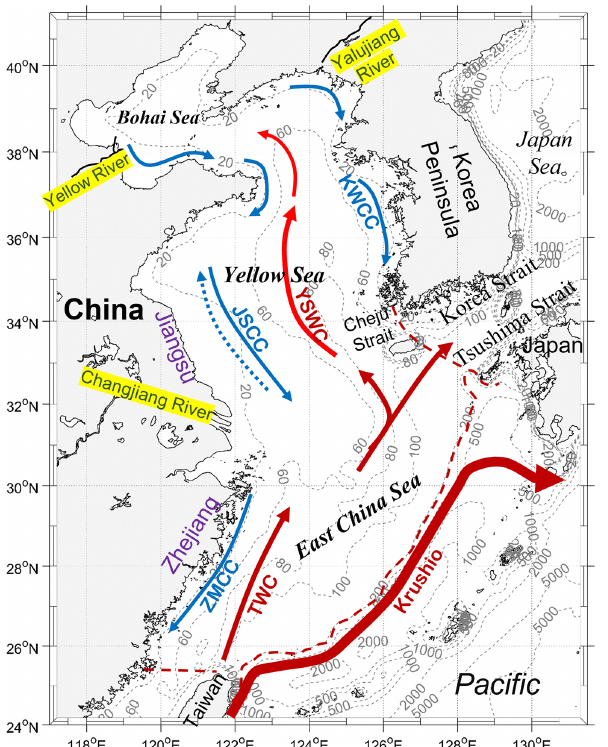
Figure 1. Model domain, locations of the Yellow, Yalujiang, and Changjiang rivers, and the primary shelf circulation in the eastern shelf seas of China. The red and blue arrows denote the primary warm currents (TWC: Taiwan Warm Current; YSWC: Yellow Sea Warm Current) and coastal currents (KWCC: Korea west coastal current; JSCC: Jiangsu coastal current; ZMCC: Zhe–Min coastal current), respectively. The blue dashed arrow denotes the JSCC in summer. The red dashed lines are the open boundary for the calcu- lation of the transit time (see Sect.